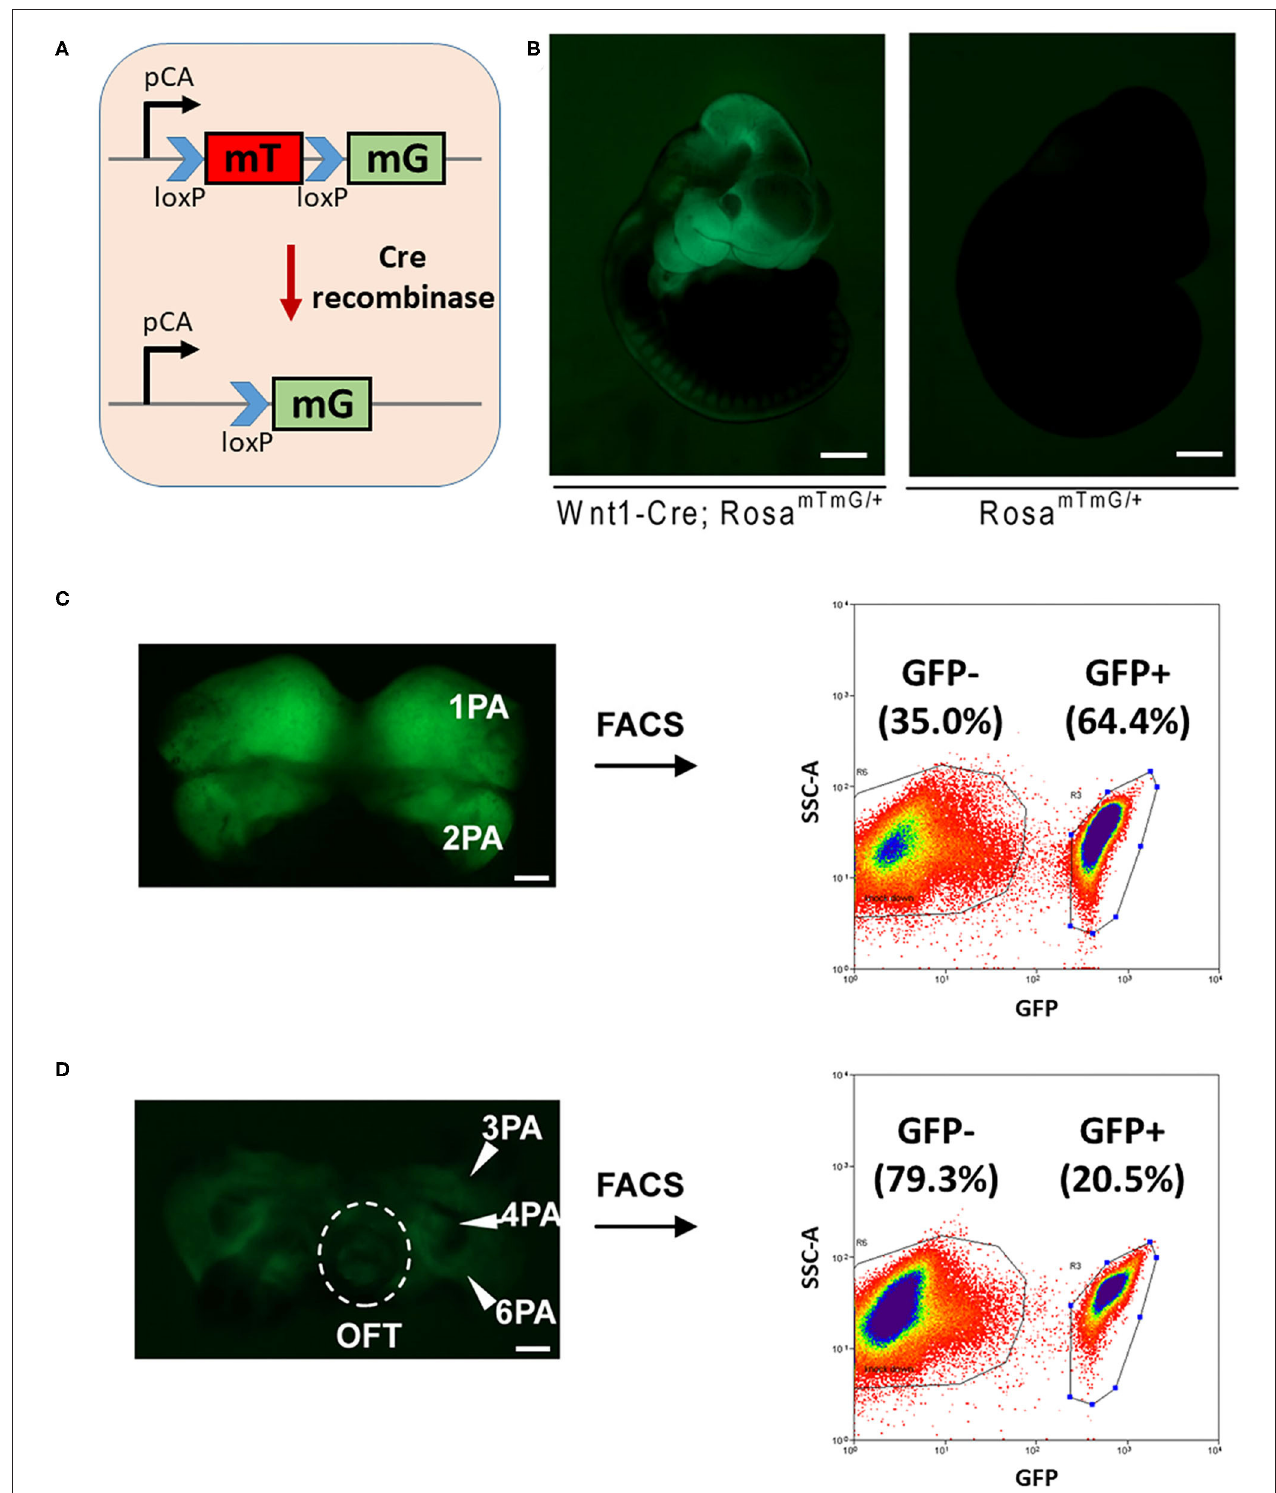
FIGURE 2 | FACS sorting of NCCs from mouse embryos for miRNA profiling. (A) A schematic figure shows the Rosa-mTmG reporter line. (B) Wnt1-Cre -mediated tissue-specific expression of GFP in E10.5 embryos. Bar = 500 µ m. The cranial-NCCs-derived tissue (C) and cardiac-NCCs-derived tissue (D) were dissected out, digested, and sorted for both GFP positive NCCs and GFP negative cells. Bar = 100 µ m. PA, pharyngeal arch; OFT, outflow tract; FACS, fluorescence-activated cell sorting; NCCs neural crest cells; miRNA, microRNA; GFP, green fluorescent protein.